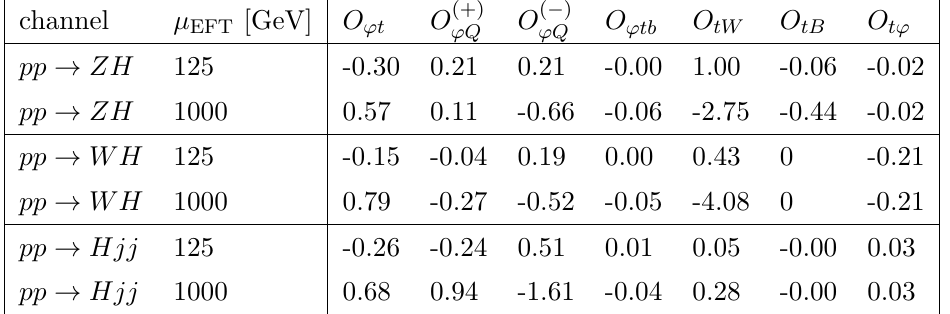
Table 2 . Percentage deviation (cid:22) ij for production channel i and operator j at LHC 13 TeV.